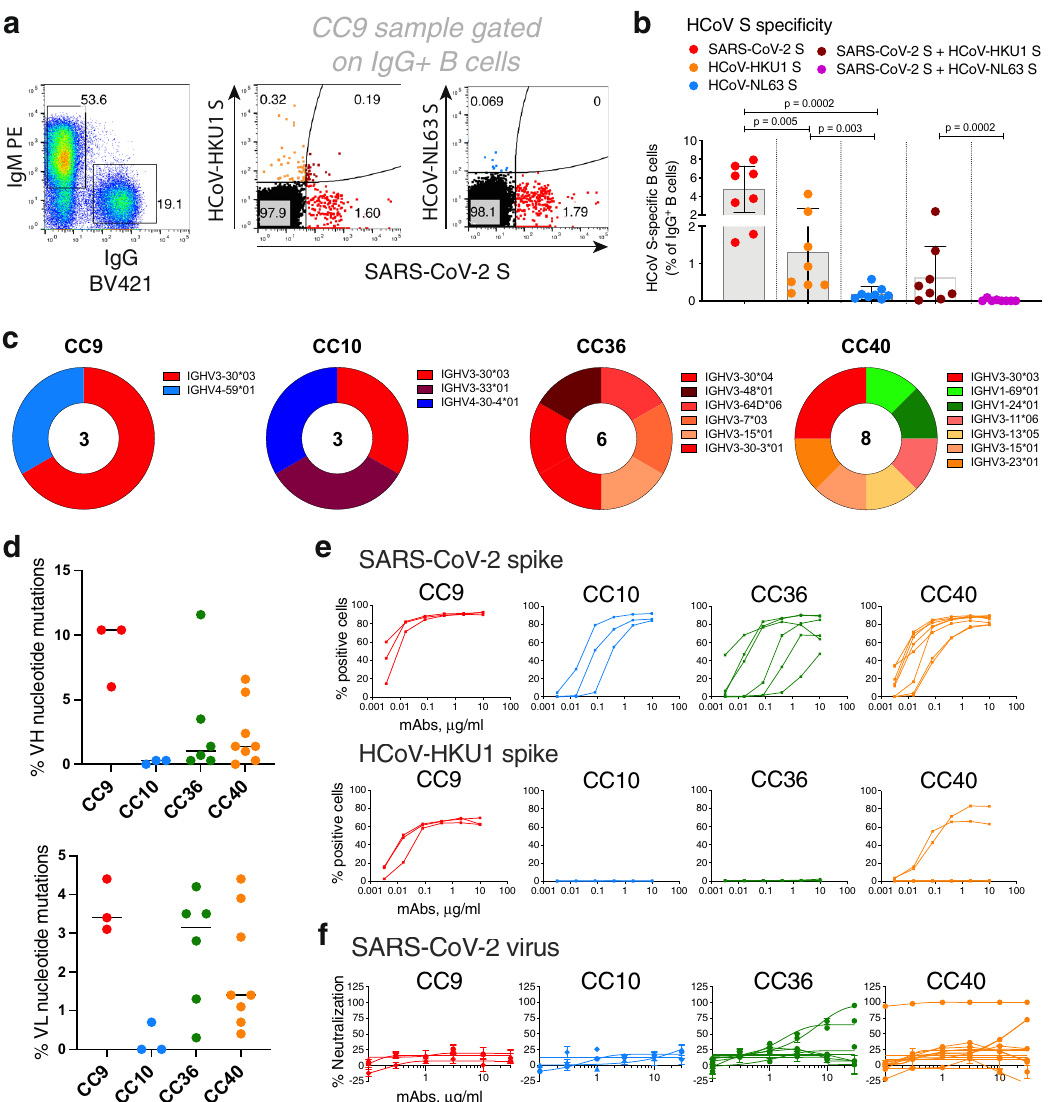
Fig. 3 SARS-CoV-2 S and endemic HCoV S-protein-speci fi c cross-reactive IgG + memory B cells from COVID donors and isolation and characterization of mAbs. a – b . Flow cytometry analysis showing the single B-cell sorting strategy for COVID representative donor CC9 and frequencies of SARS-CoV-2 S and endemic β -HCoV, HCoV-HKU1 and α -HCoV, HCoV-NL63 S-protein-speci fi c memory B cells in eight select COVID donors. The B cells were gated as SSL, CD3 − , CD4 − , CD8 − , CD14 − , IgD − CD19 + , IgM − , IgG + . The frequencies of HCoV S-protein-speci fi c IgG memory B cells were as follows; SARS- CoV-2 S (up to ~8% — range = ~1.6 – 8%), HCoV-HKU1 S (up to ~4.3% — range = ~0.2 – 4.3%), HCoV-NL63 S (up to ~0.6% – range = ~0.04 – 0.6%) protein single positive and SARS-CoV-2/HCoV-HKU1 S (up to ~2.4% – range = ~0.02 – 2.4%) and SARS-CoV-2/HCoV-NL63 S-protein (up to ~0.09% – range = ~0 – 0.09%) double positives. SARS-CoV-2-infected donors showed the presence of SARS-CoV-2/HCoV-HKU1 S-protein cross-reactive IgG memory B cells. Scatter dot plots show frequencies of S protein-speci fi c B cells with a line at mean with SD. All differences between means with p values for each comparison are indicated. ** p < 0.01; *** p < 0.001. A Mann – Whitney two-tailed test was used to compare the data groups. c Pie plots showing immunoglobulin heavy chain distribution of mAbs isolated from four COVID donors, CC9, CC10, CC36, and CC40. The majority of the mAbs were encoded by the IgVH3 immunoglobulin gene family. d Plots showing % nucleotide mutations in heavy (VH) and light (VL) chains of isolated mAbs across different individuals. The VH and VL mutations ranged from 0 to 11.6% and 0 – 4.4%, respectively, and are shown as scatter dot plots with a line at median. e CELISA-binding curves of isolated mAbs from four COVID donors with SARS-CoV-2 and HCoV-HKU1 spikes expressed on 293 T cells. Binding to HCoV spikes is recorded as % positive cells using a fl ow cytometry method. Five mAbs, three from the CC9 donor, and two from the CC40 donor show cross- reactive binding to SARS-CoV-2 and HCoV-HKU1 spikes. f Neutralization of SARS-CoV-2 by mAbs isolated from COVID donors. Four mAbs, two each from donors, CC36 and CC40, show neutralization of SARS-CoV-2. The neutralization experiments were performed in duplicate and repeated independently 1 – 2 times for